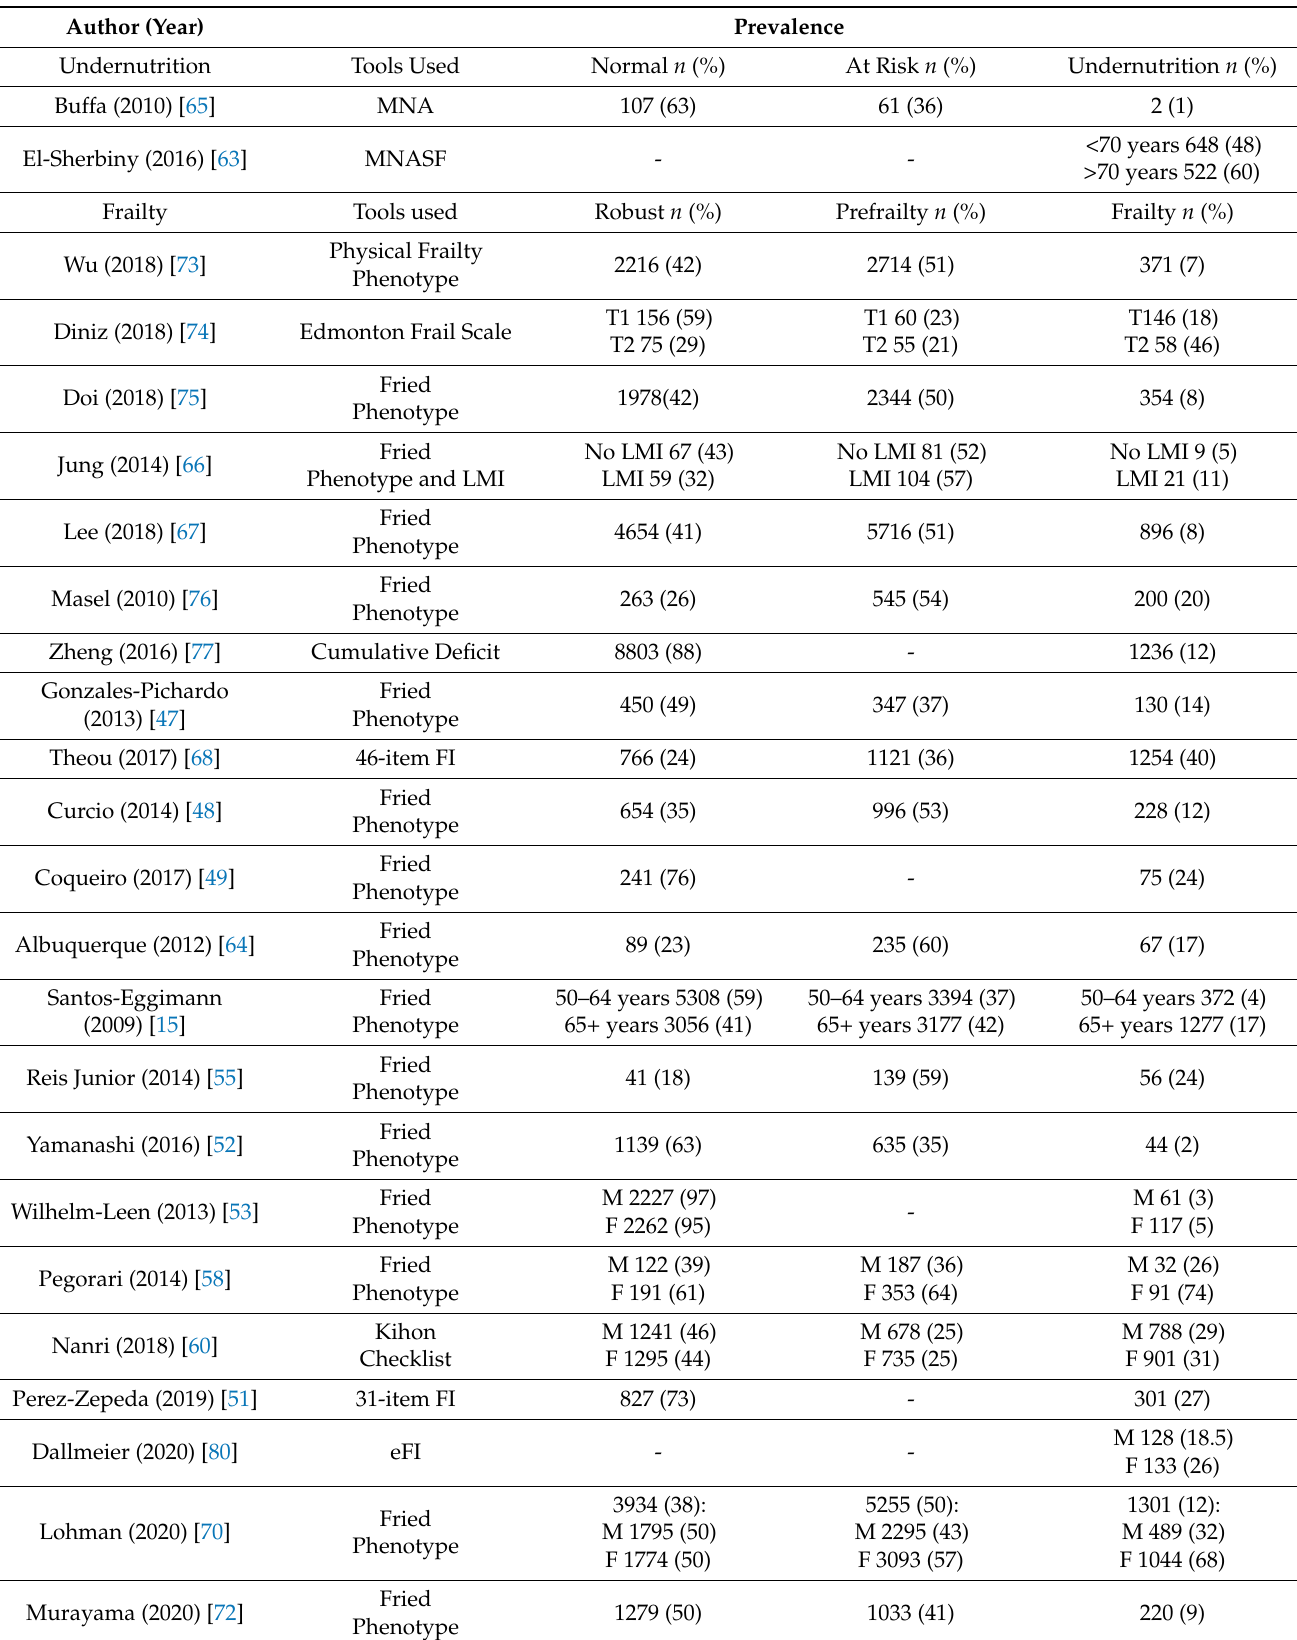
Table 2. Prevalence in studies of older people with undernutrition, frailty, or